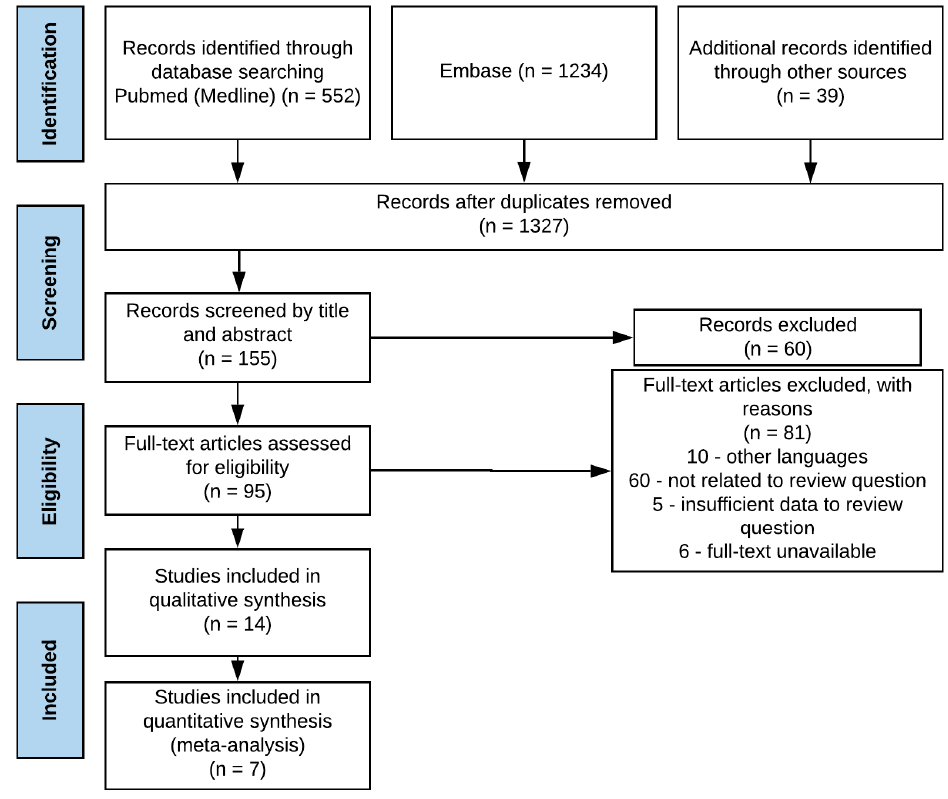
Figure 1. Search